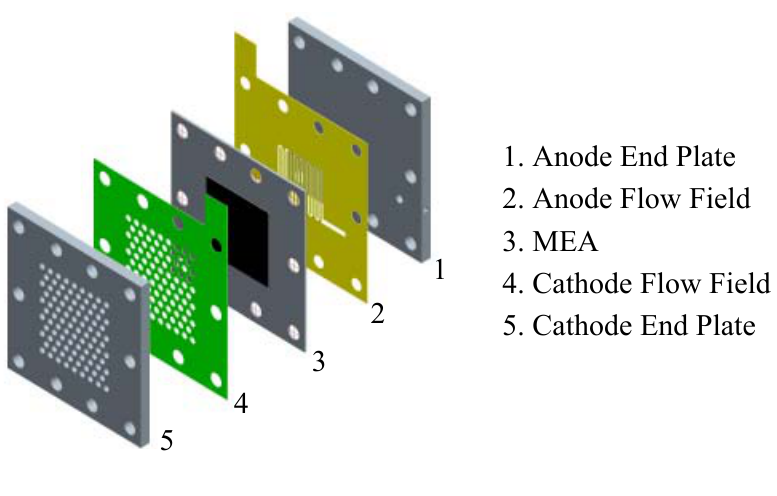
Figure 1. Infrastructure of μ